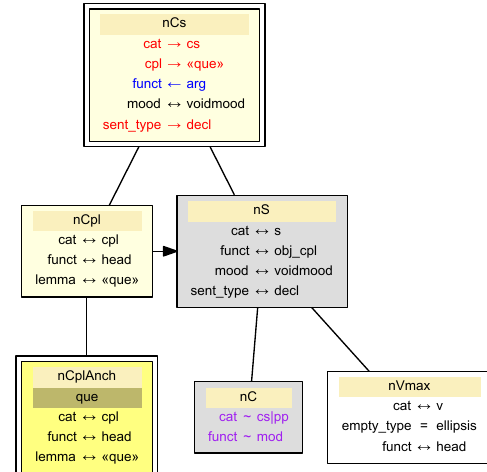
Frigram: a French Interaction Grammar